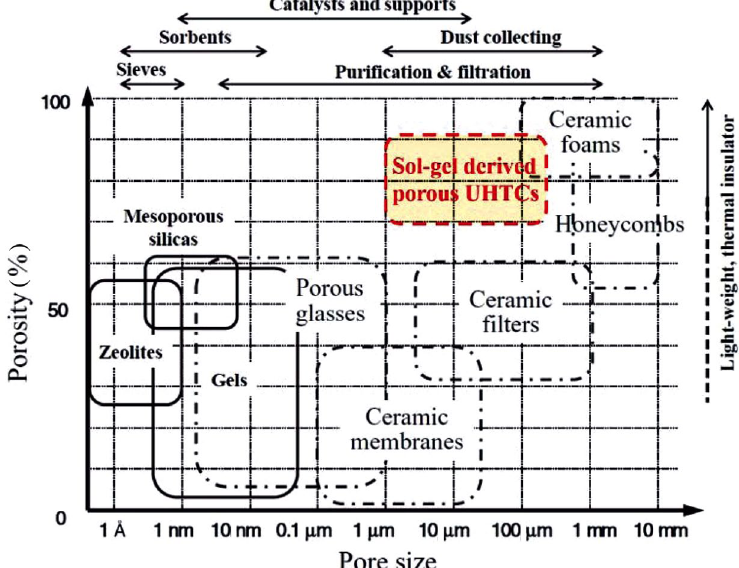
Fig. 4 Pore size and porosity of typical porous substances and ceramics [30]. Reproduced with permission from Ref. [30], © National Institute for Materials Science 2011. Table 1 Characteristics of the porous UHTCs made from various processing methods